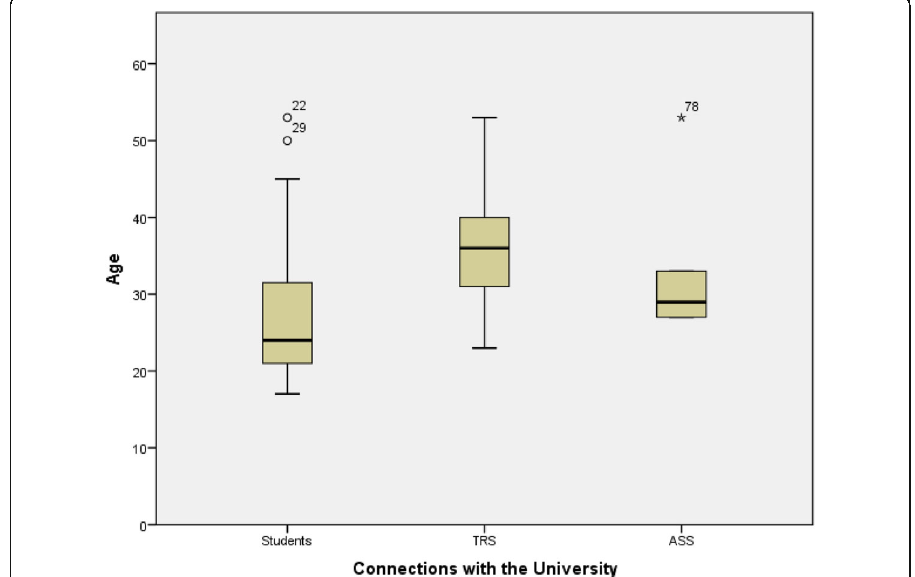
Fig. 1 Age and connections with the